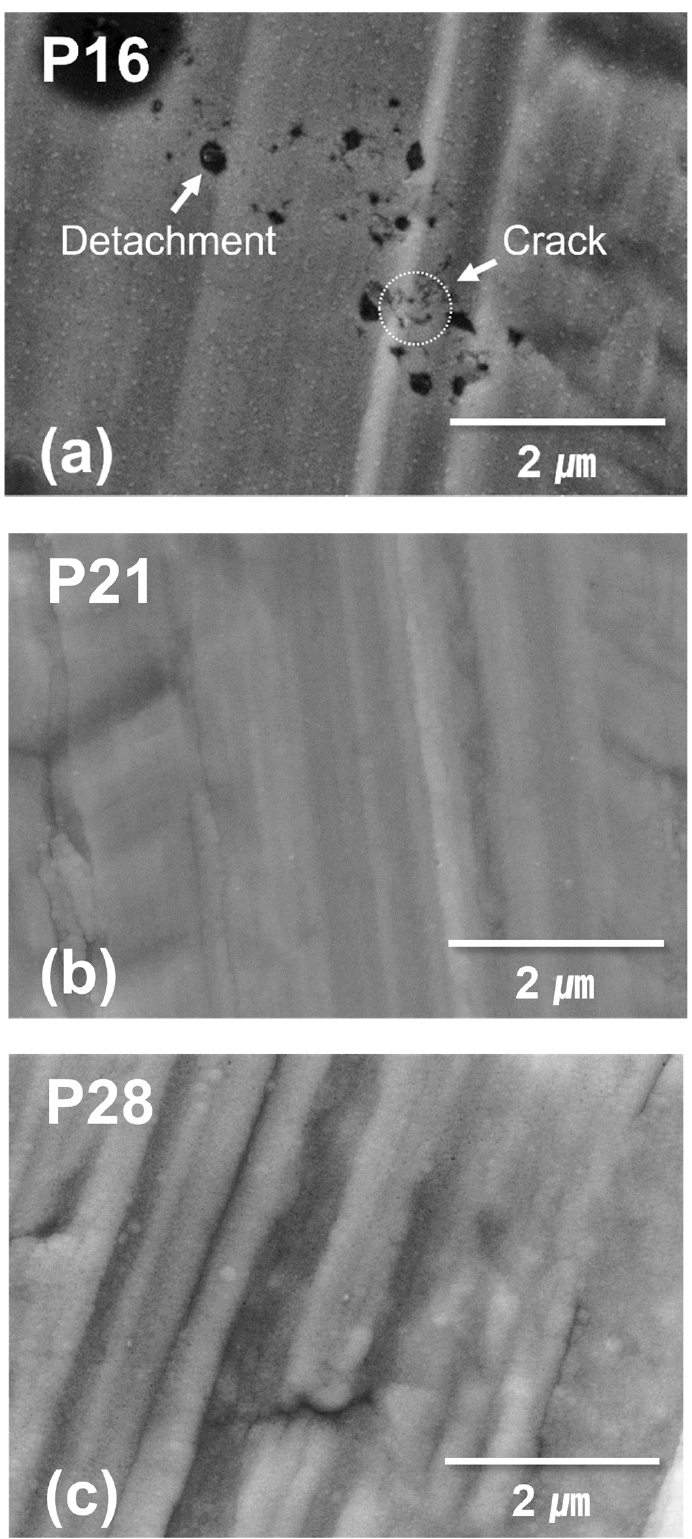
Figure 5. Scanning electron micrographs of the nickel phosphide thin films after 20 charge/discharge cycles: ( a ) sample P16, ( b ) sample P21, and ( c ) sample P28.